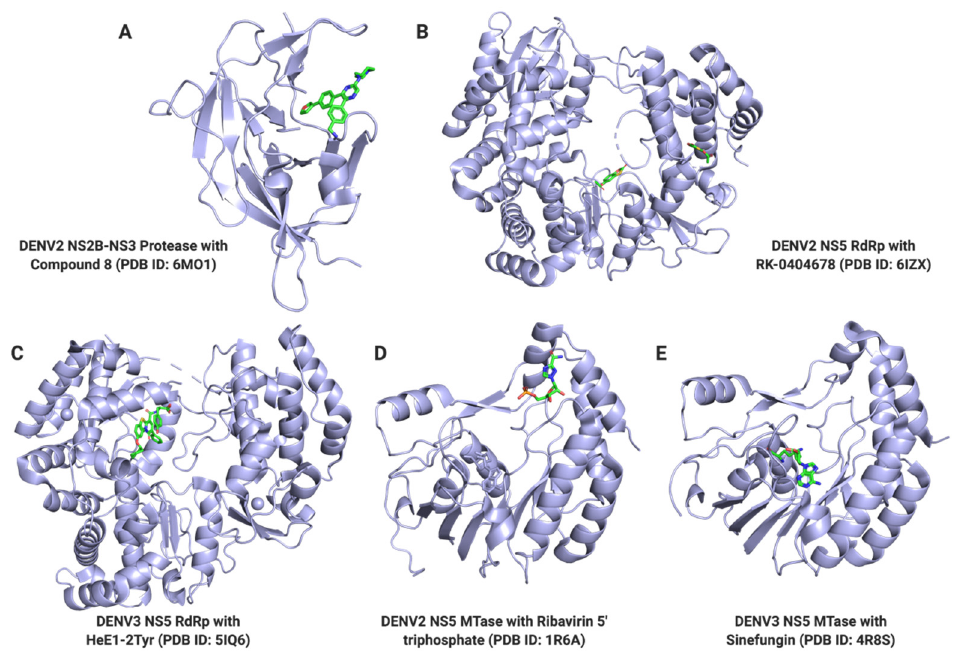
Figure 4. Representative Crystal Structures of NS3 and NS5 with Small Molecule Inhibitors. Cartoon representations of the ( A ) NS2B-NS3 protease, ( B , C ) NS5 RNA-dependent RNA polymerase (RdRp), and ( D , E ) NS5 methyltransferase (MTase) crystal structures are shown with inhibitor-bound small molecule (green sticks). ( A ) Compound 8 is bound to the protease active site of the NS3 protein; ( B ) RK-0404678 is bound to the RNA binding site of the NS5 RdRp, close to the priming loop; ( C ) HeE1-2Tyr is bound to the RNA template tunnel, between the fingers subdomain and the priming loop; ( D ) Ribavirin 5 ′ -triphosphate is bound to the GTP binding site of the NS5 MTase; ( E ) Sinefungin is bound to the SAM binding site of the NS5 MTase. All structure representations were made in PyMOL.